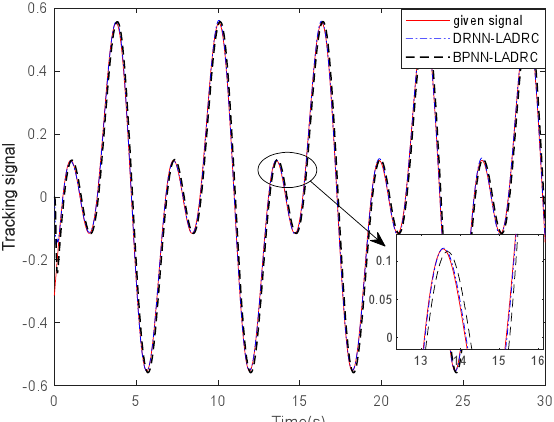
( b ) Figure 15. Curves of the internal nonlinear disturbances. ( a ) The friction nonlinearity, ( b ) The dead zone. 4.3. Case Study 3: Performance Comparison between DRNN-LADRC and BPNN-LADRC In this part, tracking control of BPNN-LADRC for the radar position servo system is simulated as compared with DRNN-LADRC, which is studied in Case Study 2. The pa- rameters of the BPNN-LADRC are given as: 0 85 w = ; the number of the neurons in the input layer, hidden layer and output layer, are 4, 5 and 2, respectively. Additionally, the initial value of the weight vectors with respect to the hidden layer and output layer are also random vectors in a certain range. The remaining parameters and input signal are invariant, just as in Case Study 2. The tracking outputs of the DRNN-LADRC and BPNN-LADRC for the radar system are demonstrated in Figure 16, and the tracking errors are shown in Figure 17. It is clear from Figure 17 that the proposed DRNN-LADRC has better control performance com- pared with the BPNN-LADRC. It can be seen that the DRNN-LADRC has higher control accuracy and will be more effective in high-precision control. In addition, the tracking